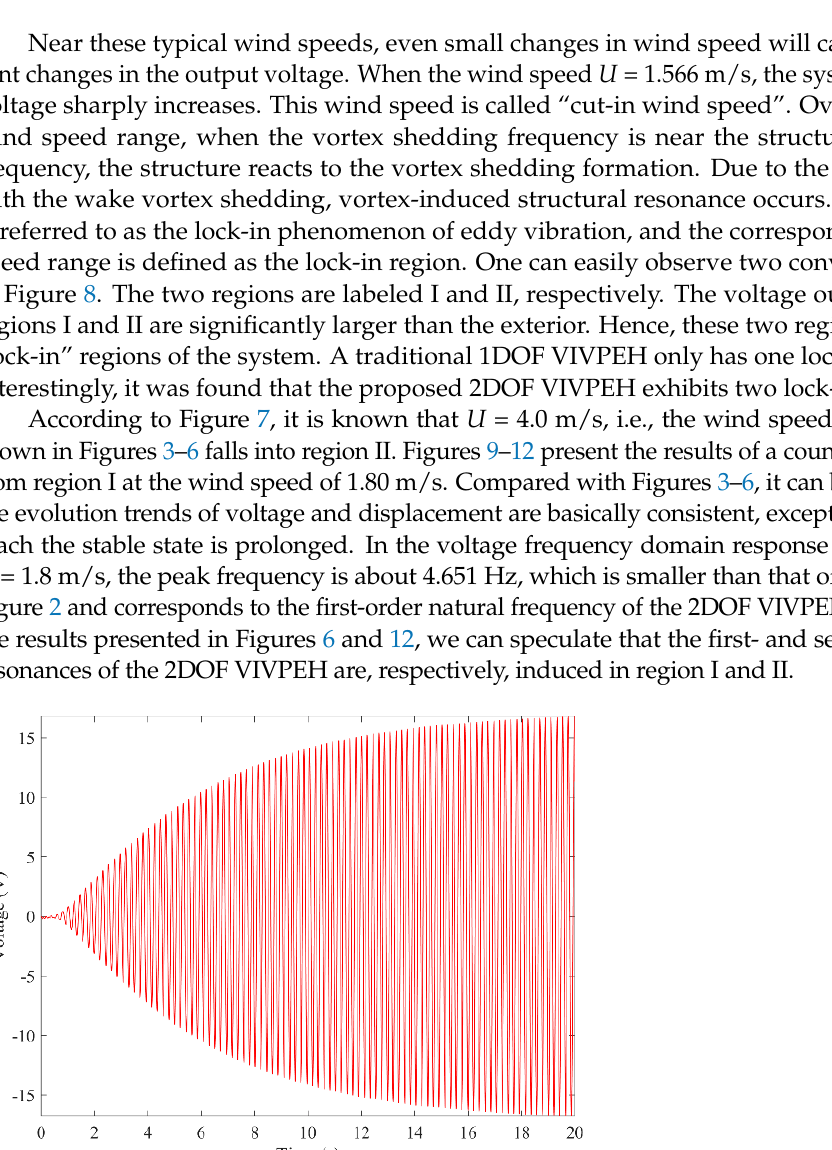
Figure 11. Time–history displacement response ( U = 1.8 m/s).